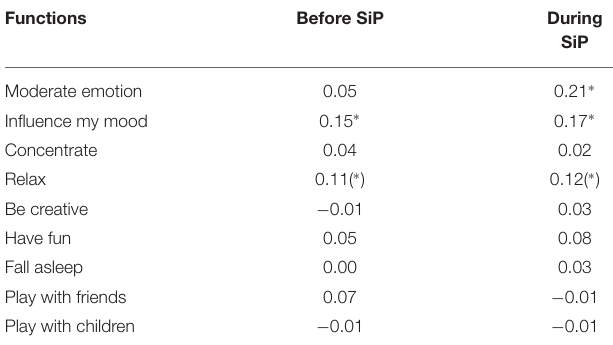
TABLE 11 | The functional use of music before and after shelter-in-place. TABLE 12 | Correlation (Spearman’s ρ ) between stress-level change (SLC) and 9 functions of music before and during SiP ∗ p < 0.05, ( ∗ ) p < 0.1, Holm-Bonferroni